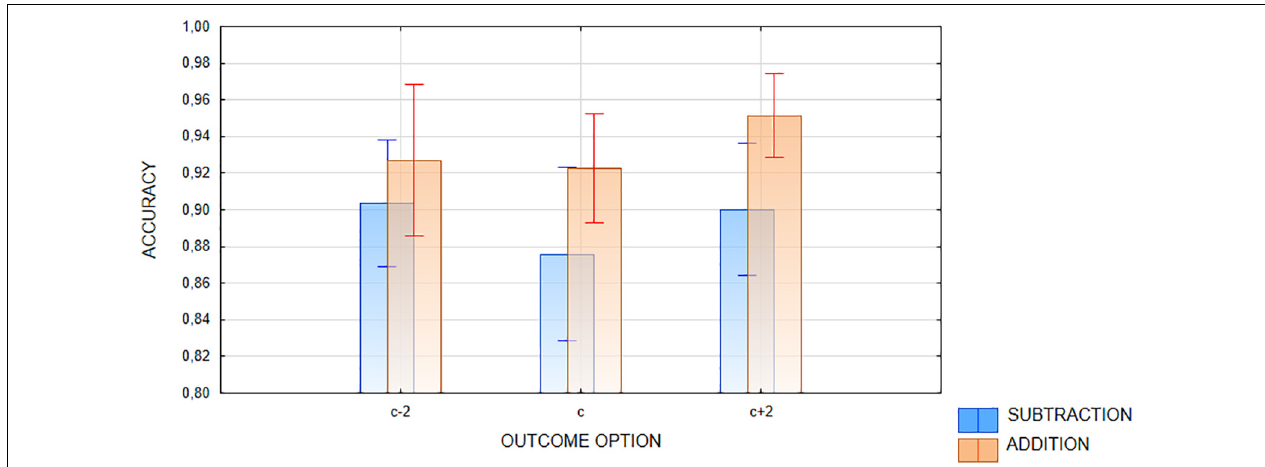
FIGURE 3 | Response accuracy. Interaction between OPERATION (addition vs. subtraction) and OUTCOME OPTION (c + 2 vs. c–2) factors. Rods represent standard error. Correct outcome option was not included in the analysis and is added for illustration purposes only.